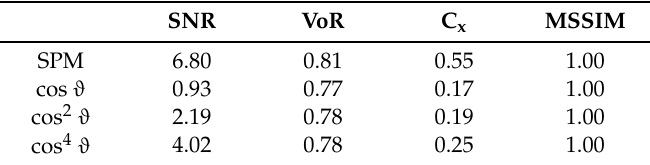
Table 2. Performance parameters of SB-SARBM3D.